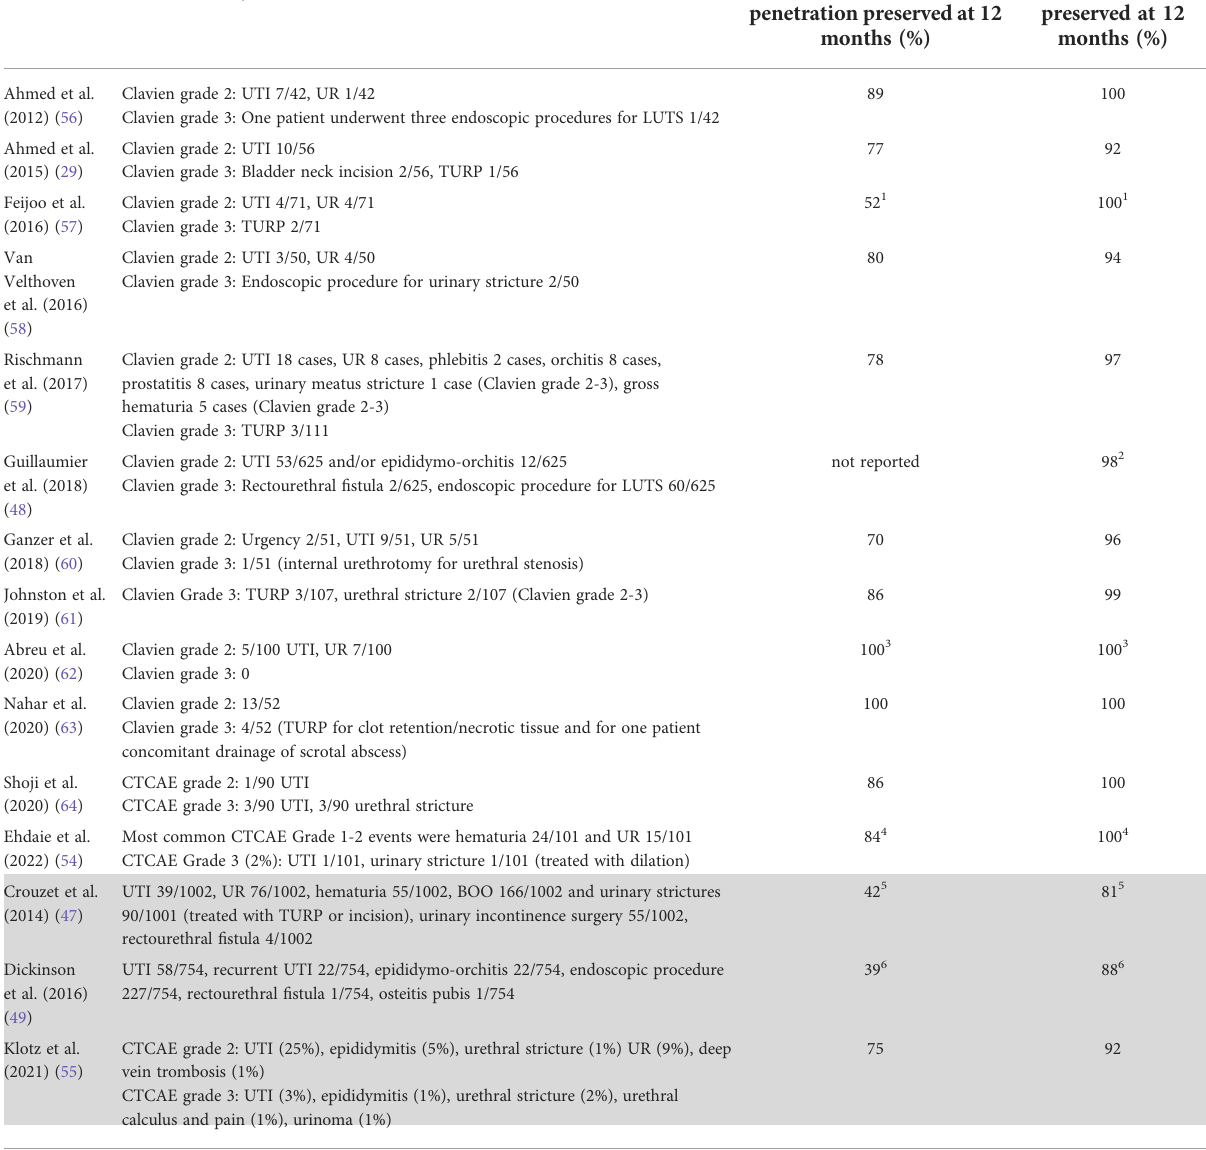
TABLE 1 Safety and functional outcomes of the studies evaluating ultrasound ablation of primary localized prostate cancer. Author Safety (Clavien Dindo or CTCAE when available) Erections suf fi cient for